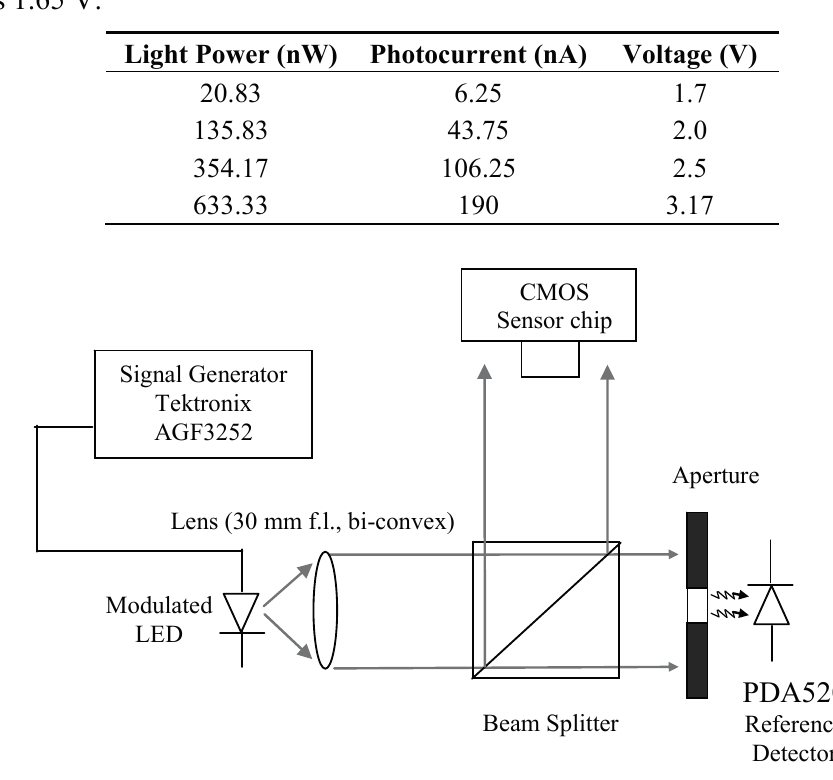
Figure 3. Optical setup for laboratory characterization of the I/V converter and band-pass filters. The ac and dc light levels of the λ = 640 nm red LED (KINGBRIGHT—L-7104SRC-J4) is controlled by a signal generator (Tektronix AGF3252). The reference photodiode (PDA520) has a known transimpedance gain and is used to calculate the light falling on the CMOS